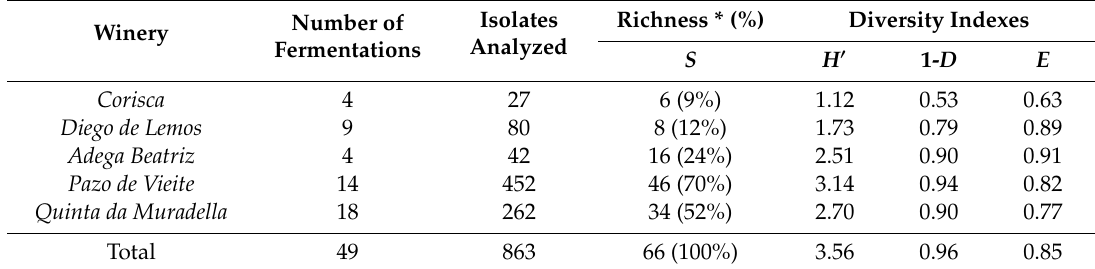
Table 2. Diversity of S. cerevisiae strains in organic wineries from Galicia.